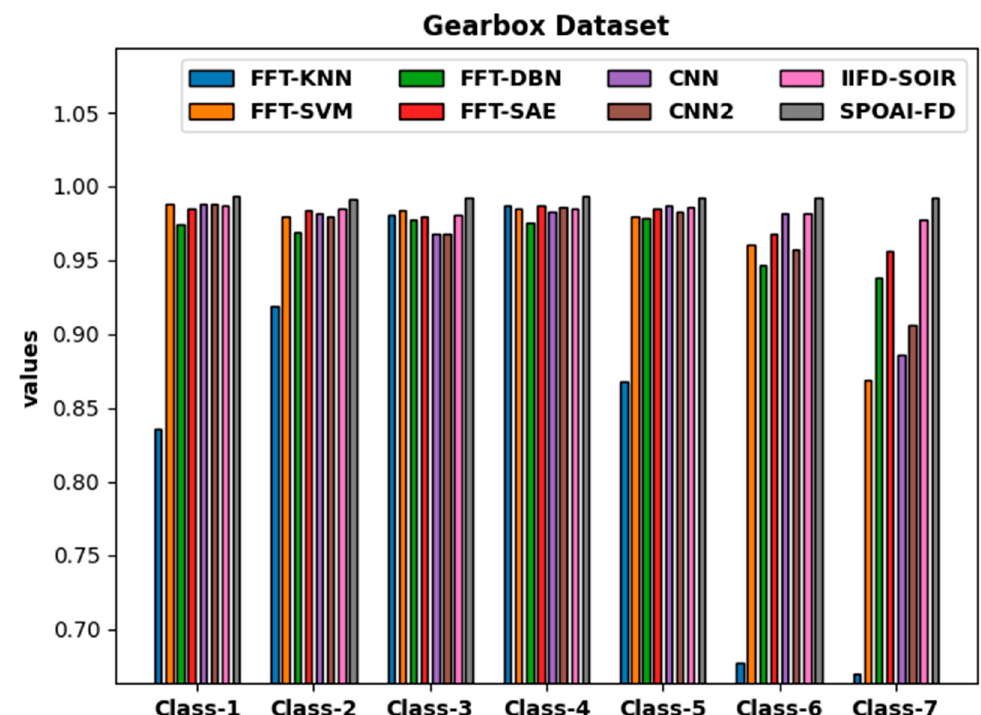
Figure 3. Accuracy analysis results of SPOAI-FD technique under Gearbox dataset.